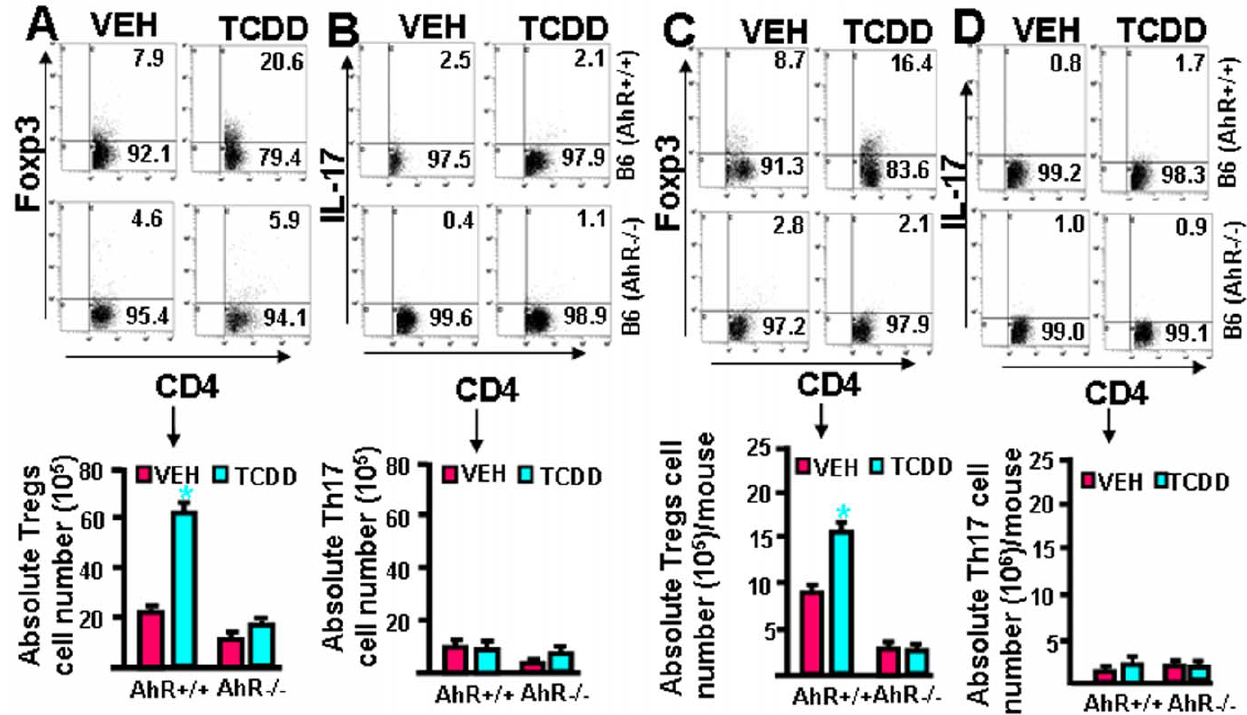
Figure 5. TCDD requires AhR to induce reciprocal differentiation of Tregs and Th17 cells invitro and invivo. In panels A and B, T cells from C57BL/6 wild-type (AhR + / + ) and knockout (AhR -/- ) mice were cultured in the presence of anti-mouse CD3 (2 m g/ml) and CD28 (1 m g/ml) mAbs for 72 hrs. These cells were simultaneously treated with VEH or TCDD (100 nM/ml). The cells were stained for Tregs (CD4 + FoxP-3 + ) and Th17 (CD4 + IL- 17 + ) cells. In panels C and D, C57BL/6 wild type (AhR + / + ) and knockout (AhR -/- ) mice were injected with VEH or TCDD and 5 days later, spleen cells were analyzed for Tregs (CD4 + FoxP-3 + ) and Th17 (CD4 + IL-17 + ) cells. Both percentages and absolute numbers of Tregs and Th17 cells were depicted. Vertical bars represent data (mean 6 SEM) from three independent experiments. Statistical comparisons were made between TCDD and VEH-treated groups and asterisks (*) represent statistically significant (p , 0.05) differences.